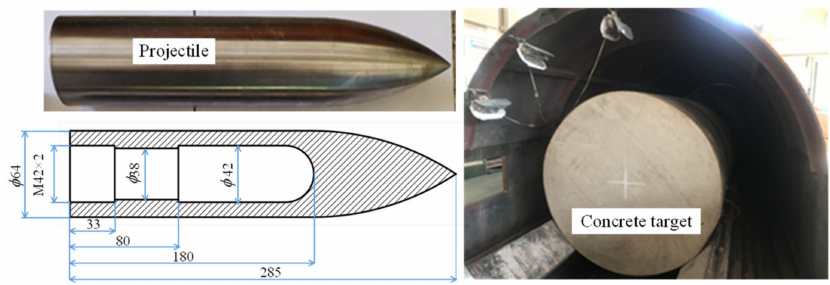
Figure 8. Projectile and target (units: mm) (source elaborated by